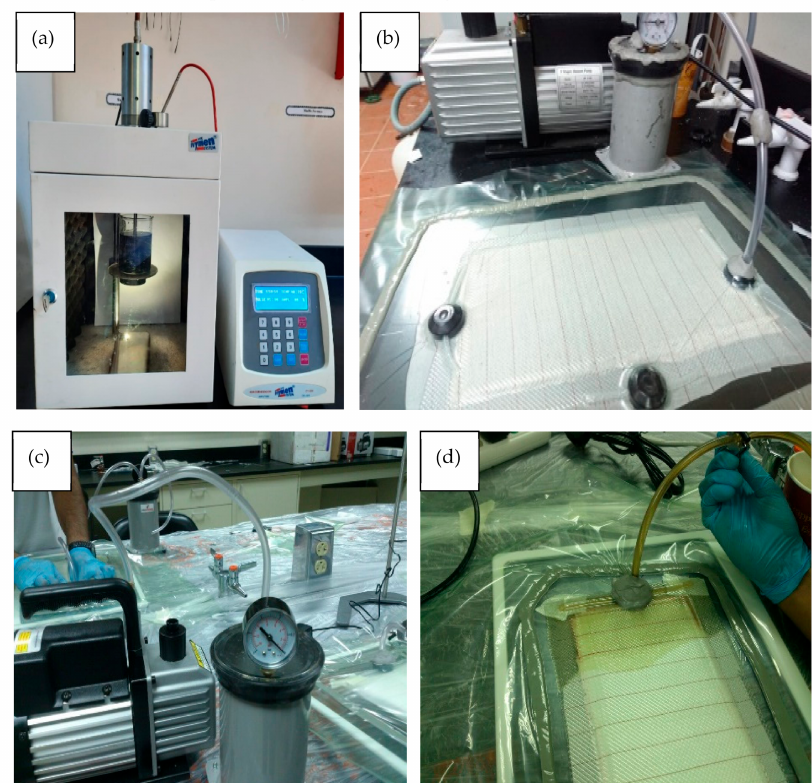
Figure 3. Synthesis and fabrication of Kevlar/epoxy/MWCNTs nanocomposite: ( a ) mixing epoxy/MWCNTs using sonication technique, ( b ) VIP tools, ( c ) evacuation process, and ( d ) fiber impregnation by the epoxy/MWCNTs mixture.